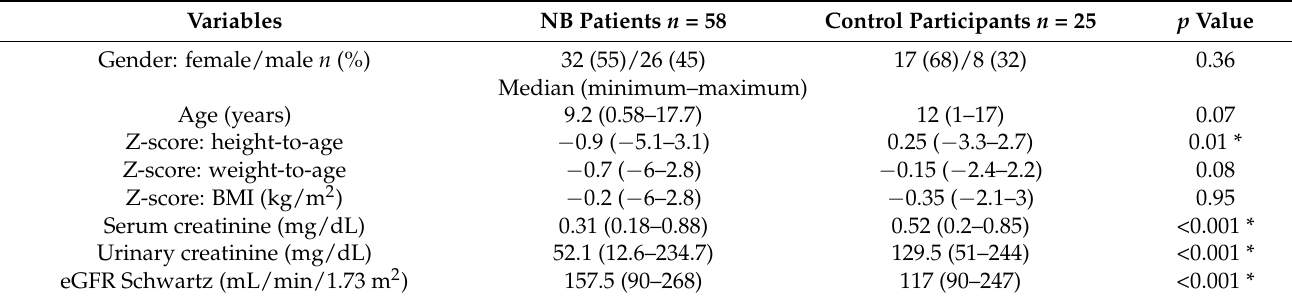
Table 1. Demographic characteristics of patients with NB and control participants.